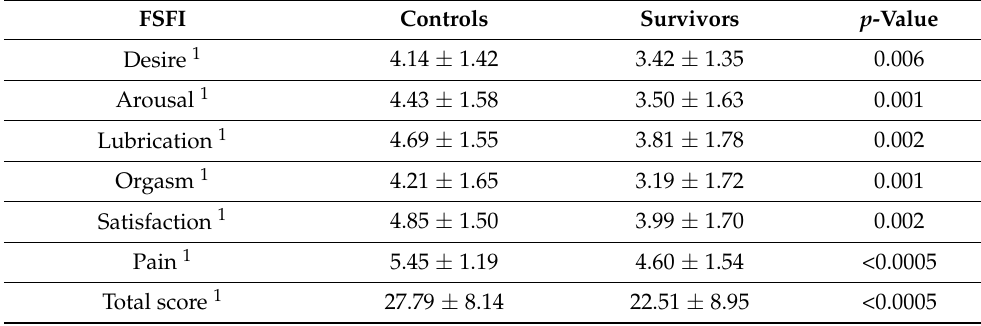
Table 2. FSFI scores of survivors and